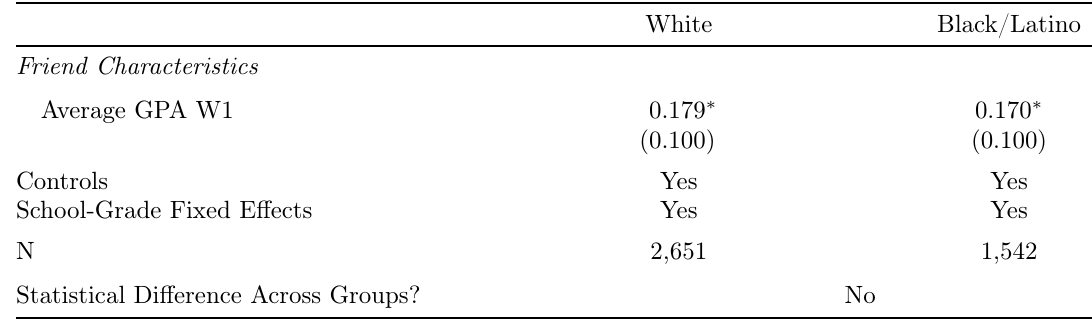
Table 3: Parameter Estimates from IV Analyses Predicting Academic Achievement by